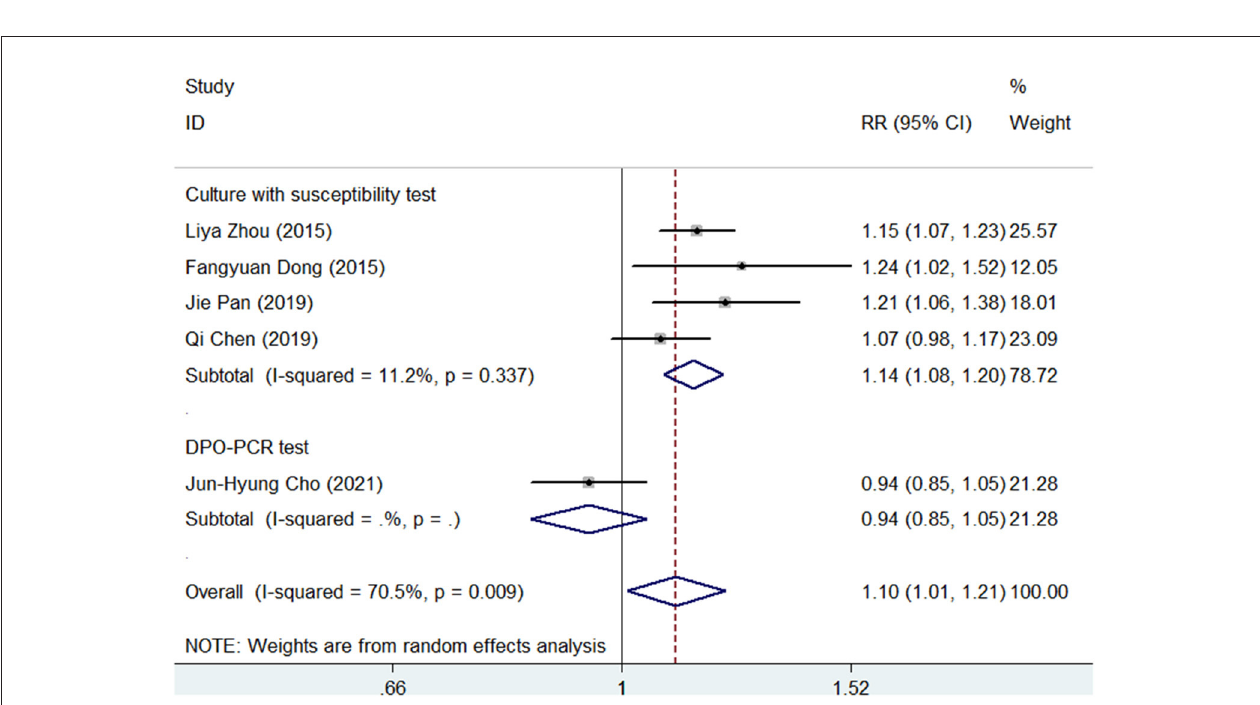
especially in areas with high antibiotic resistance. Theoretically, a susceptibility test is the best choice for guiding a tailored therapy for H. pylori infection. If not available, empiric BQT